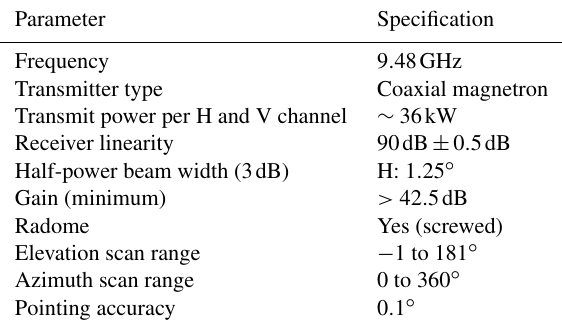
Table 2. Specifications of the mobile METEOR 50DX dual- polarization weather radar used for the measurement campaigns in 2019 and 2020. The abbreviations H and V stand for horizontal and vertical polarization,